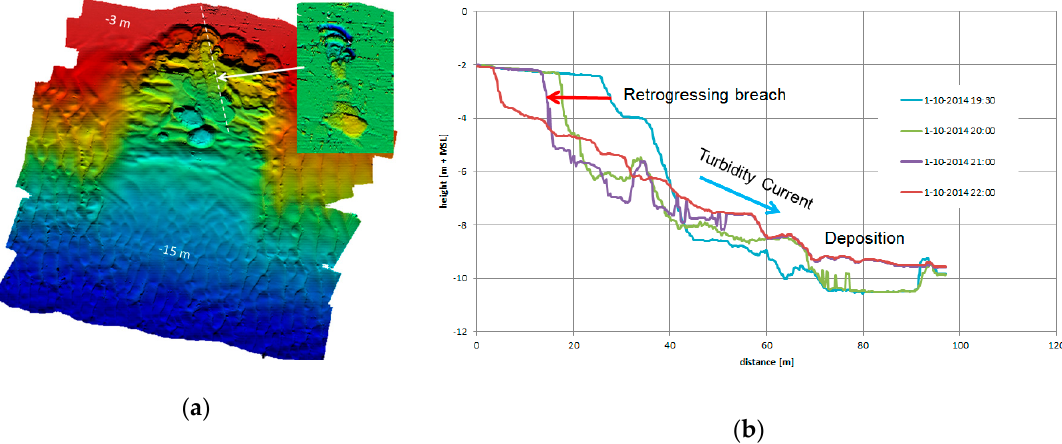
Figure 10. Flood Control flow slide test in 2014. ( a ) Bathymetry of dredging area (100 × 100 m) with small flow slide scars (below low-water line). Inserted: Differential bathymetry (blue = erosion, yellow = deposition). ( b ) Cross section along dashed line in (a) showing breach retrogression for 2.5 hours, sand deposition and breach height of about 6 m. STOWA, Amersfoort, 2015 [47].